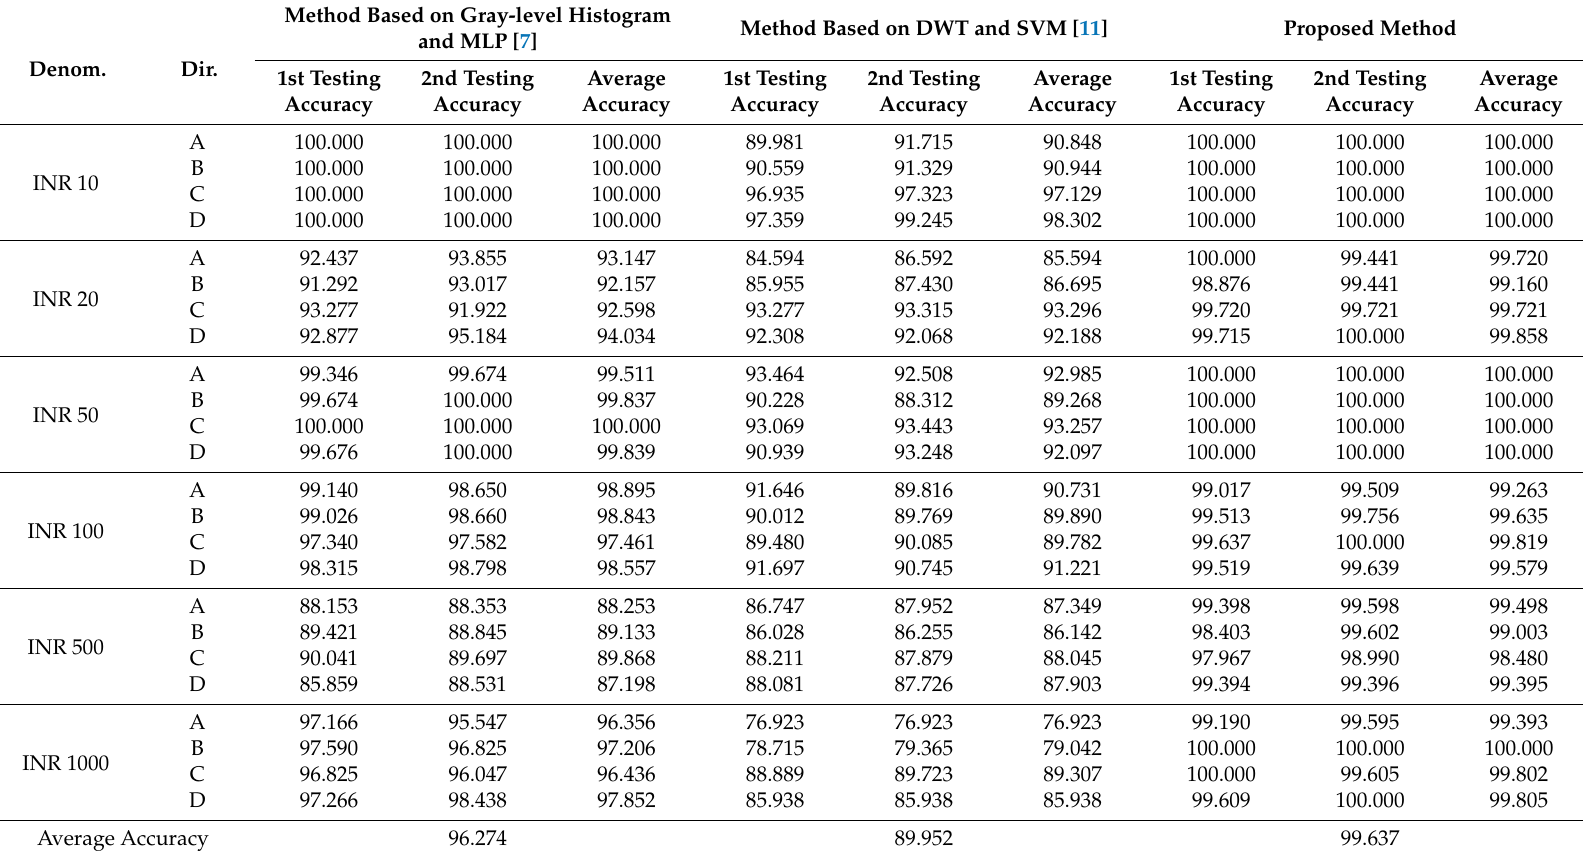
Table 8. Comparison of fitness-classification accuracy by our proposed method with that of previous studies on the INR banknote dataset. Denom., Dir., 1st Testing Results and 2nd Testing Results mean the same as those in Table 7 (unit: %).